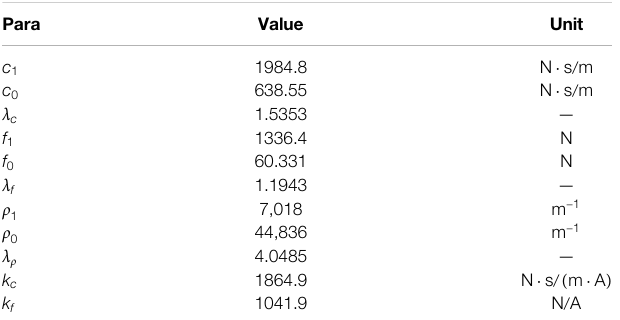
TABLE 1 | Fitting results of MR damper